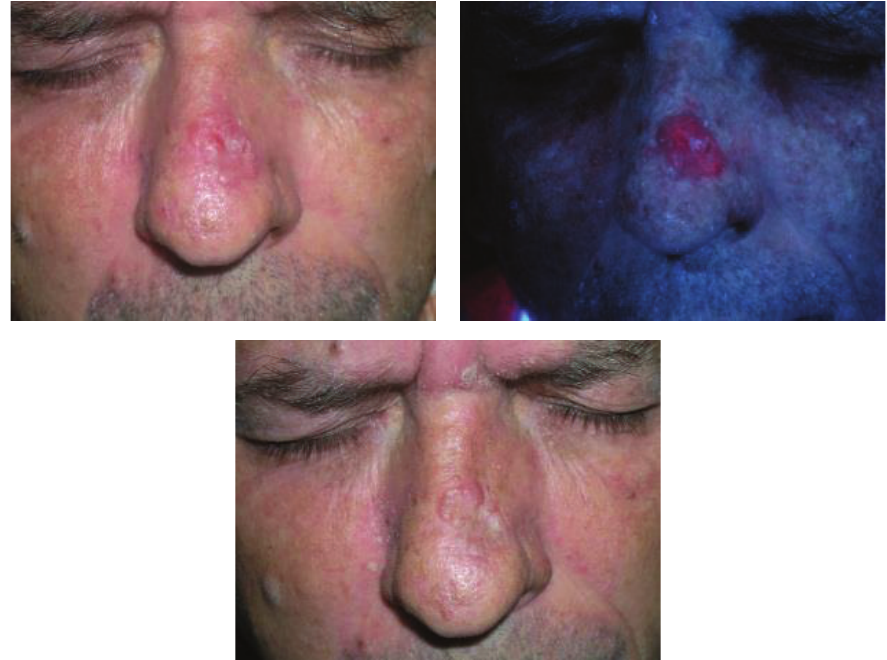
Figure 4: Nodular BCC in the nose. Exact fluorescence and incomplete